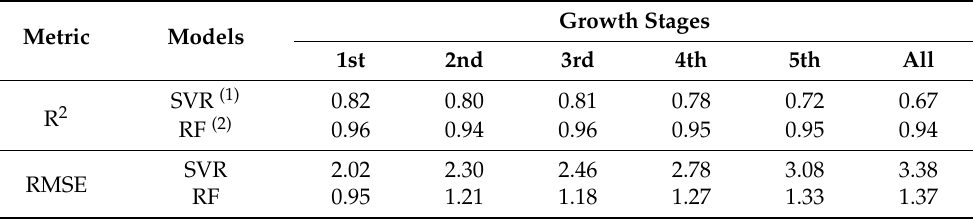
Table 7. R 2 and RMSE of calibration datasets in the machine learning models.